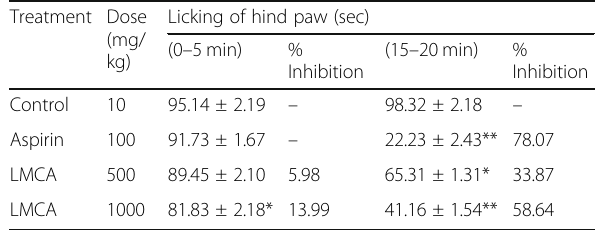
Table 5 Effect of LMCA in Formalin induced paw licking test